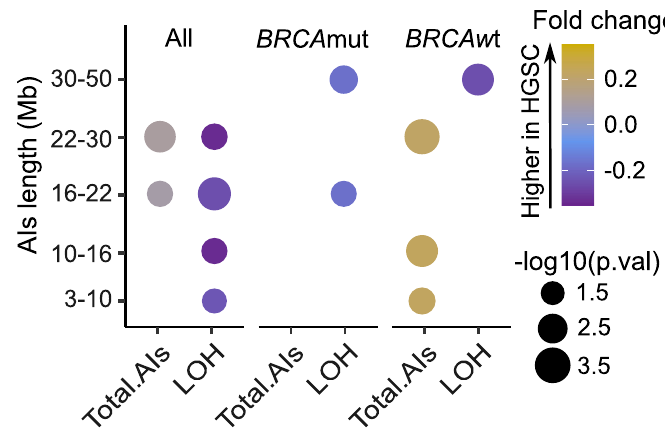
lung adenocarcinoma (LUAD), breast invasive carcinoma (BRCA), and HGSC) with a higher amount but a lower median length of AIs (upper cluster: Fig. 1d). The second cluster consisting of the remaining 12 cancer types (lower cluster: Fig. 1d). The same